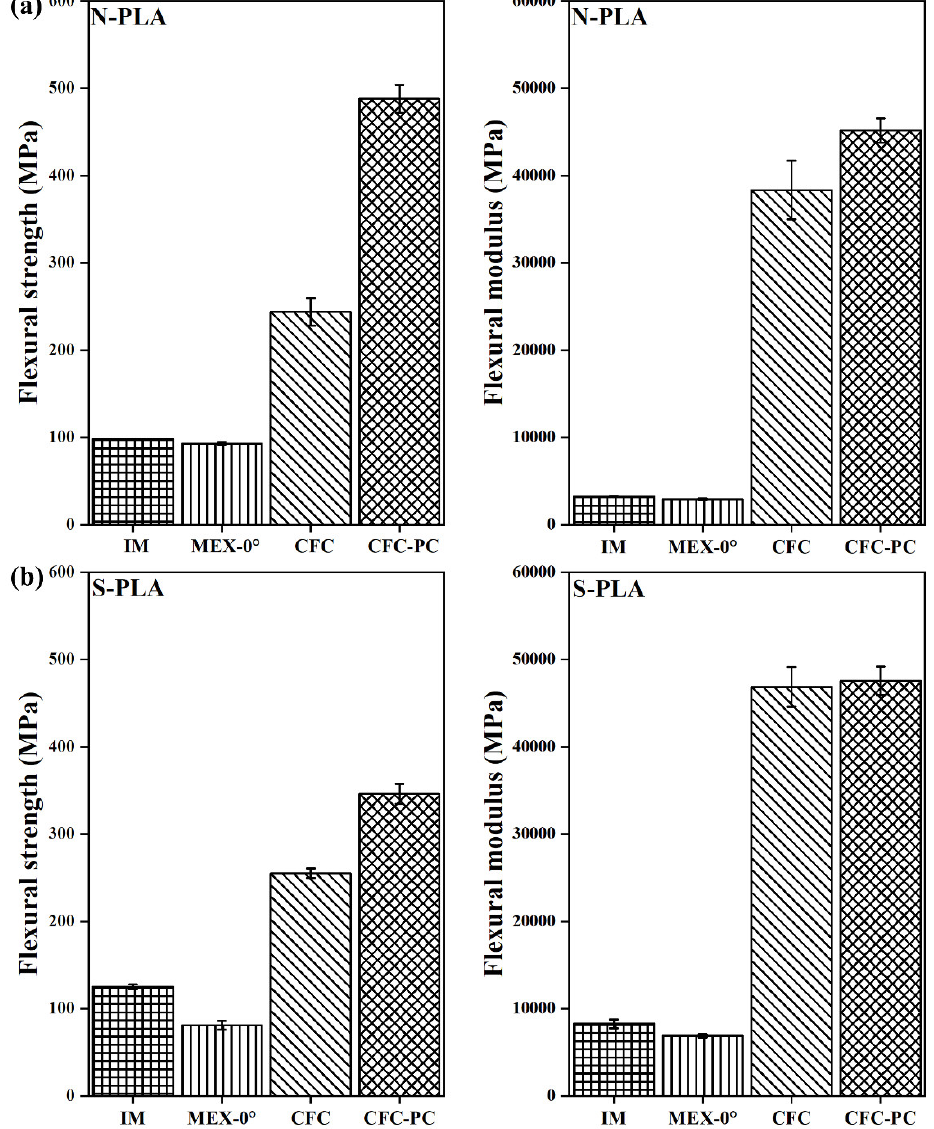
Figure 7. Flexural test data of PLA with a corresponding error bar. Where, N-PLA is neat PLA and S-PLA is short carbon fibre filled PLA. The corresponding IM, MEX-0 ◦ , CFC, and CFC-PC are injection moulded, 3D printed, composite filament co-extruded, and post-processed composite filament co-extruded 3D printed 4-pointing beding tested specimens,